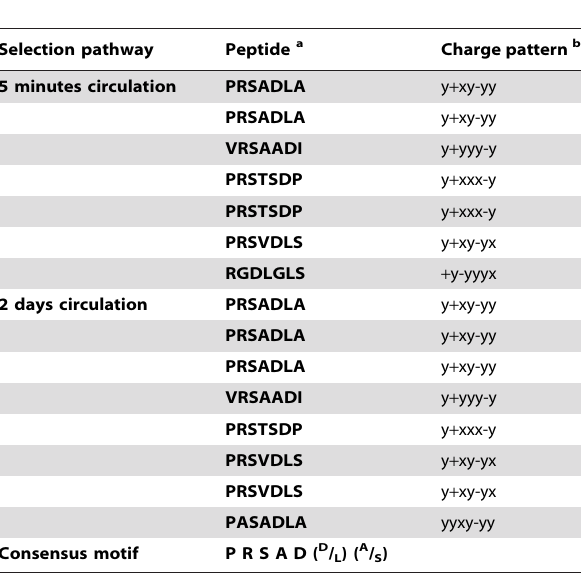
a single letter code; shared amino acid patterns are highlighted in red letters b charge pattern of amino acid side chains: + , positively charged; 2 negatively charged; x, uncharged polar; y, nonpolar.